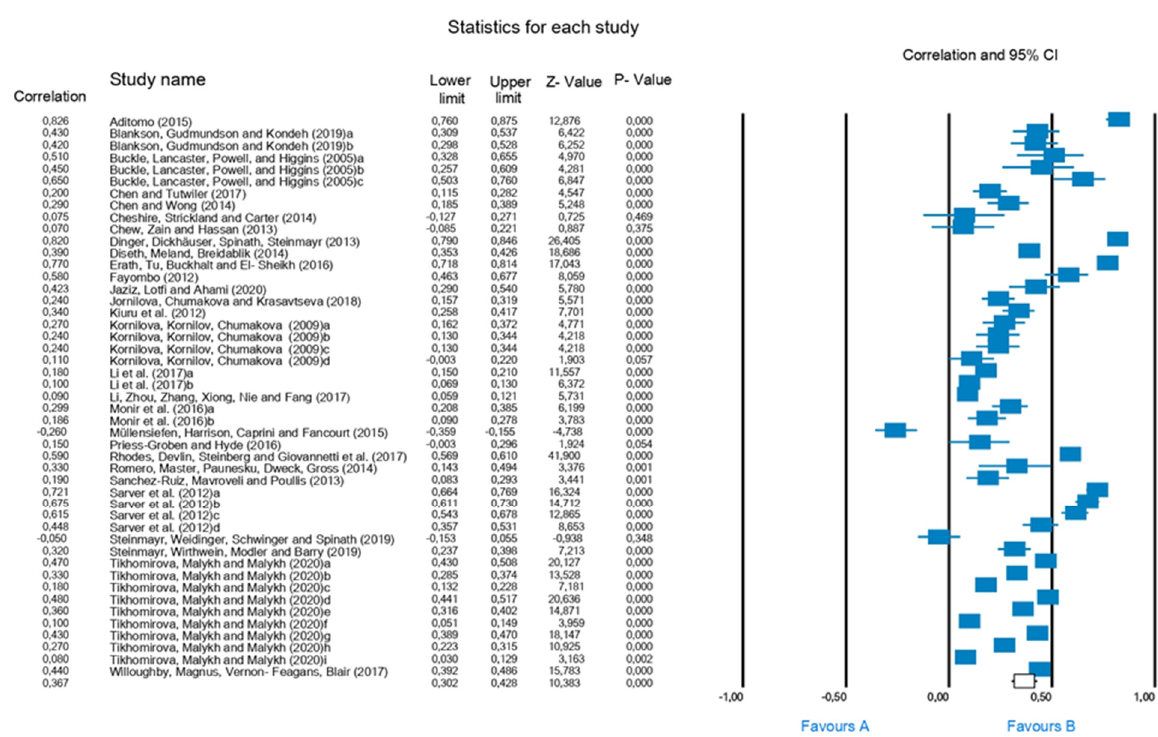
Figure 2. Forest Plot.